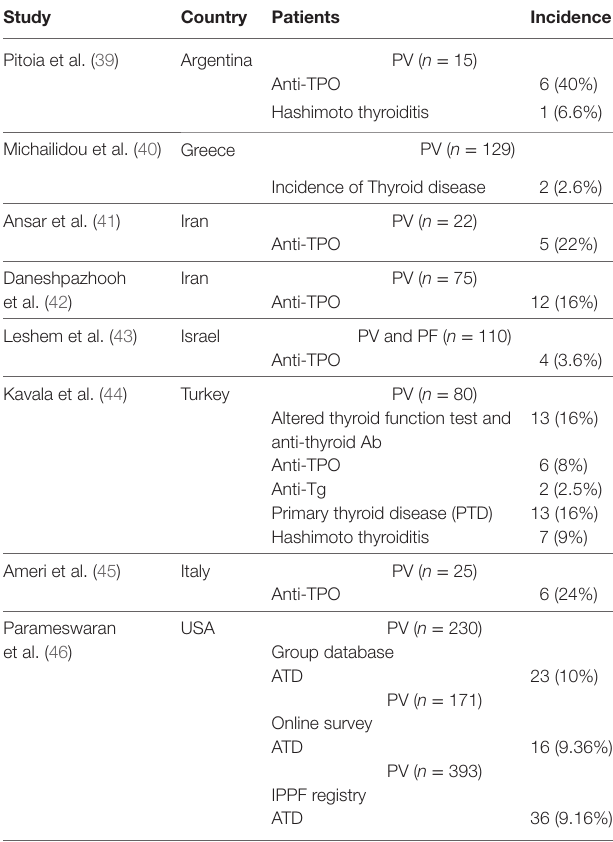
TABLe 2 | Current studies on the incidence of thyroid autoantibodies and thyroid disease in patients with pemphigus.